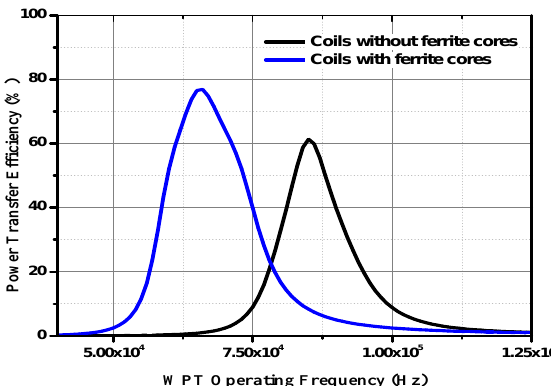
Figure 7. Power transfer efficiency in the absence and the presence of ferrite cores after readjusting the capacitors.